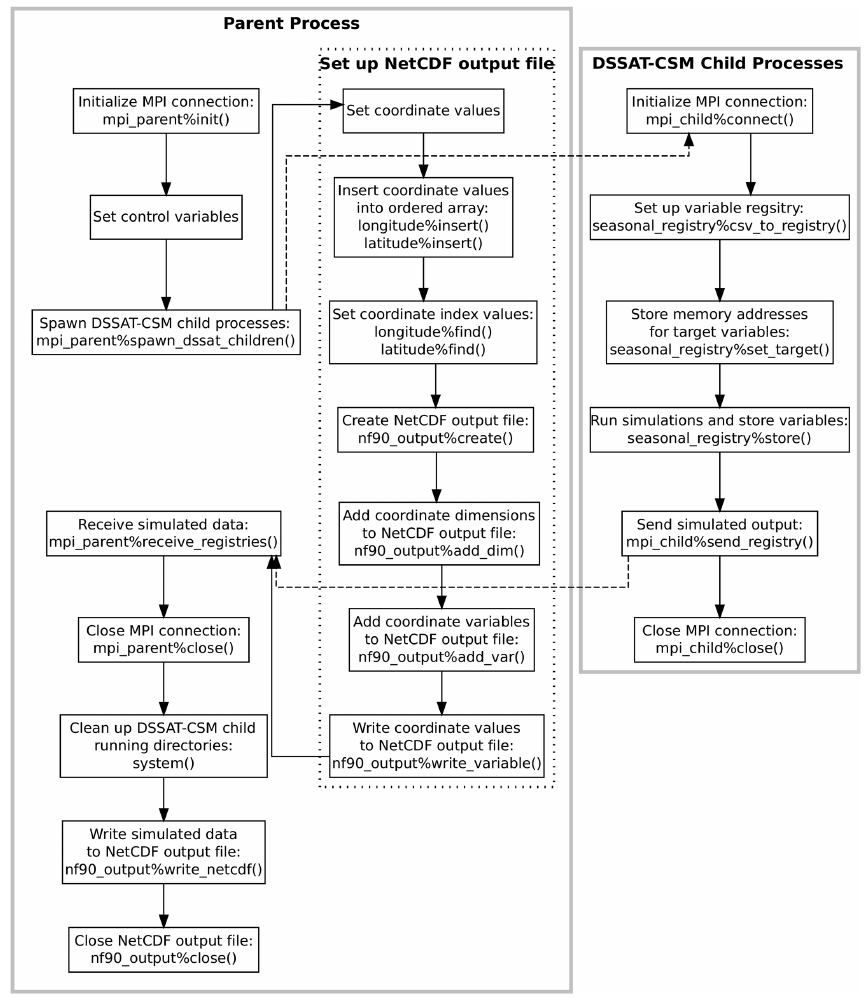
Figure 3. Flowchart illustrating the points of communication and sequence of operations for the example parent and child programs given in Appendices C and D and explained in Sect. 2.3. Solid gray borders indicate the boundary of a process. The dotted border indicates a grouping of operations within a given process. Dashed arrows indicate communication between processes using Message Passing Interface (MPI)